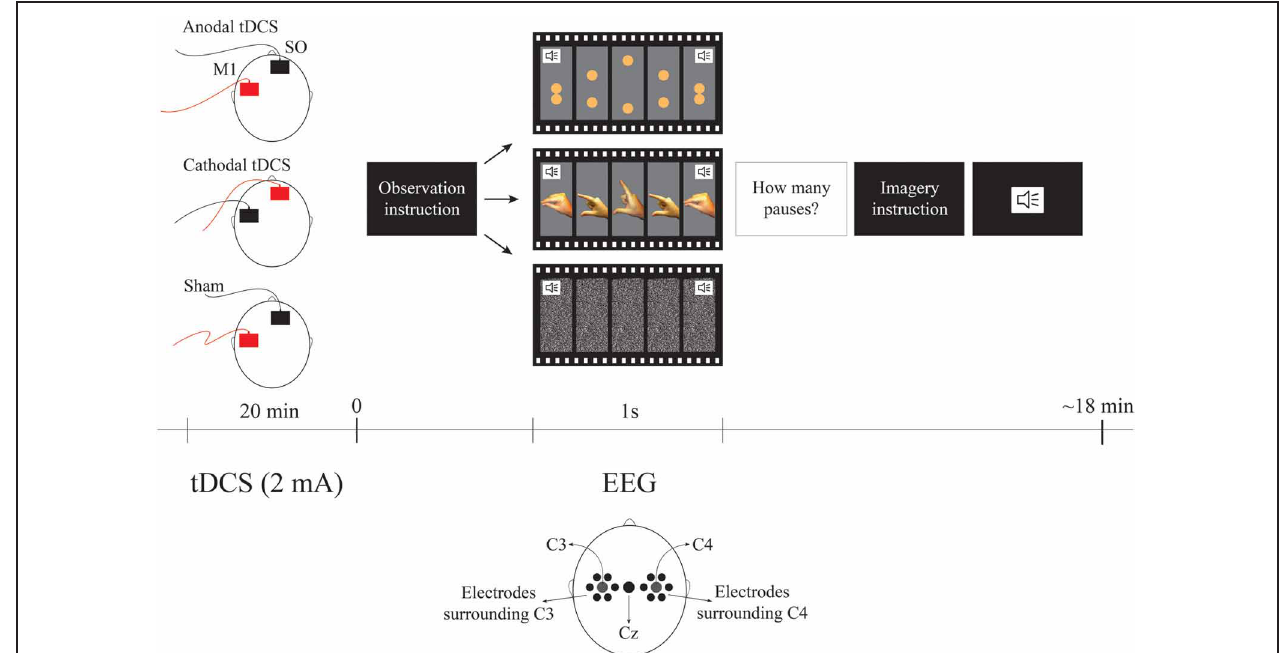
111). The sound symbols represent the moment when the metronome stimulus occurs pacing each cycle. For tDCS conditions red represents the anode and black represents cathode. SO represents the supraorbital (reference)